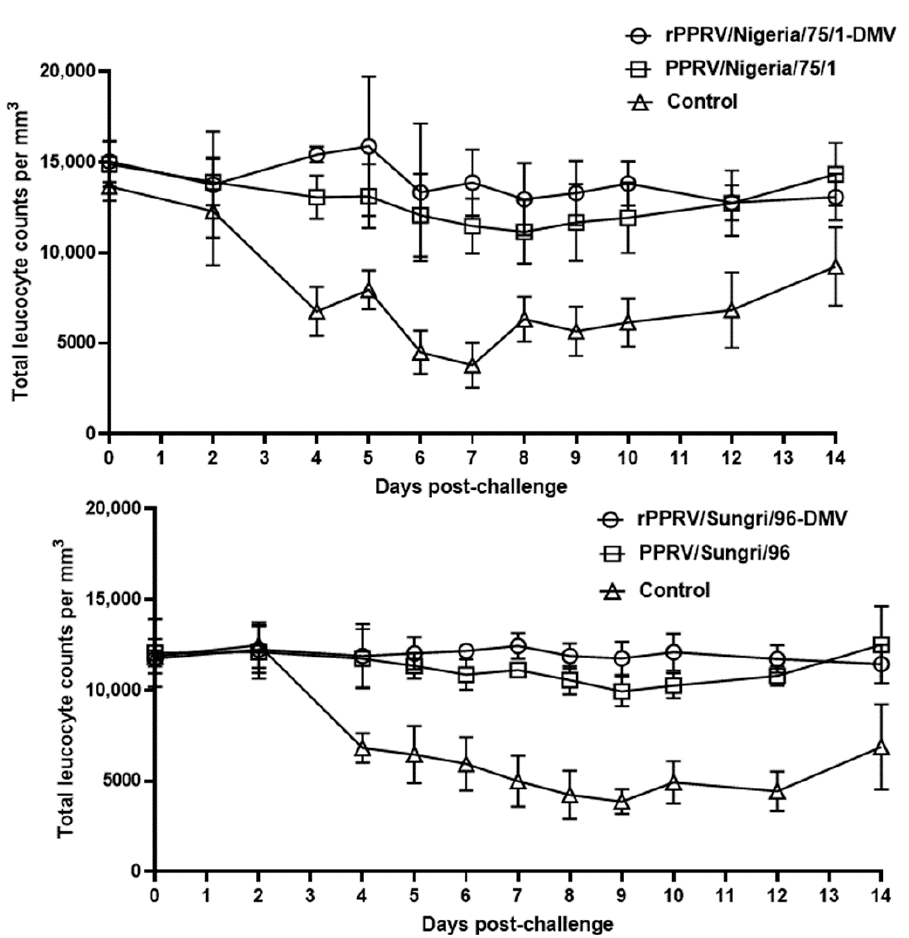
Figure 5. Leukocyte counts for the vaccinated and unvaccinated goats on the virulent PPRV challenge. The total number of leukocytes were counted using a hemocytometer and expressed as the total number of WBCs per ml of blood. The mean values of five animals in each group with ± standard error of mean is shown. After 10 days post-challenge, the control group data are presented as the mean values of 2 and 4 animals in the Sungri/96 and Nigeria/75/1 experimental groups, respectively.